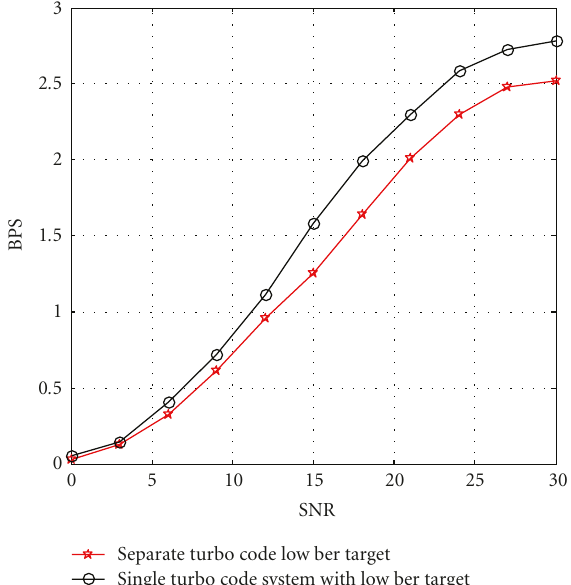
Figure 13: Throughput of separate turbo code system and one turbo code system with BER target 10 − 4